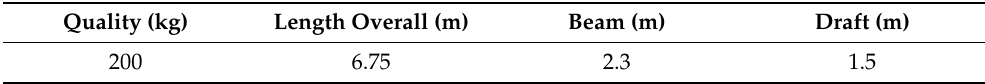
Table 7. Basic parameters of